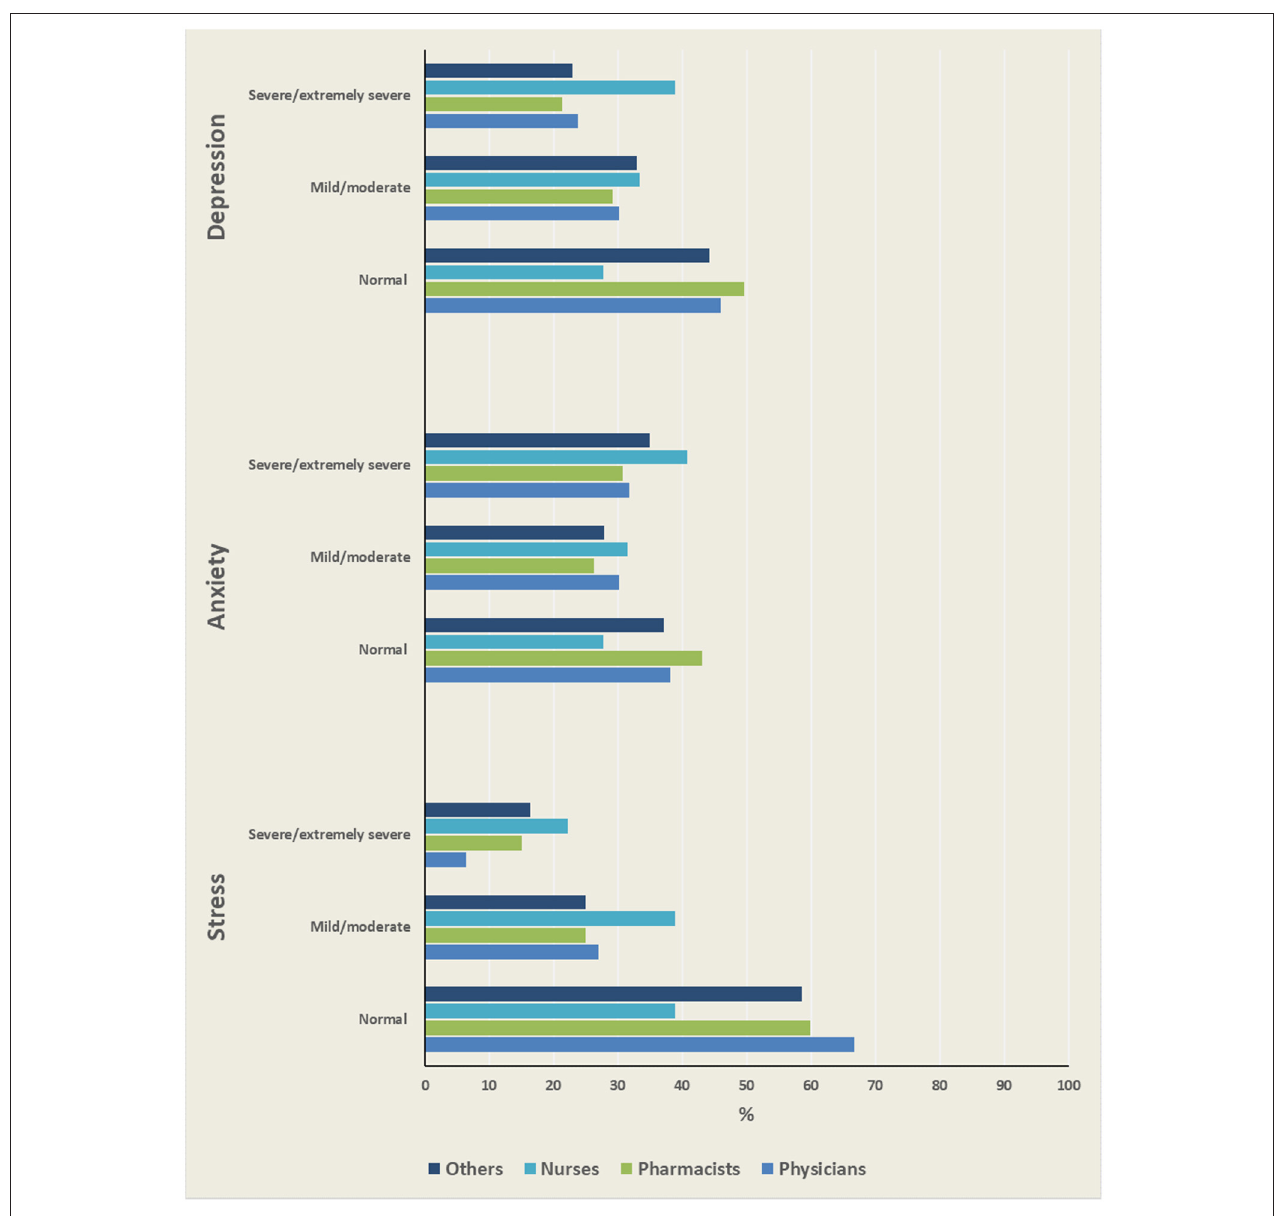
FIGURE 1 | Severity levels of psychological disorders among HCWs.